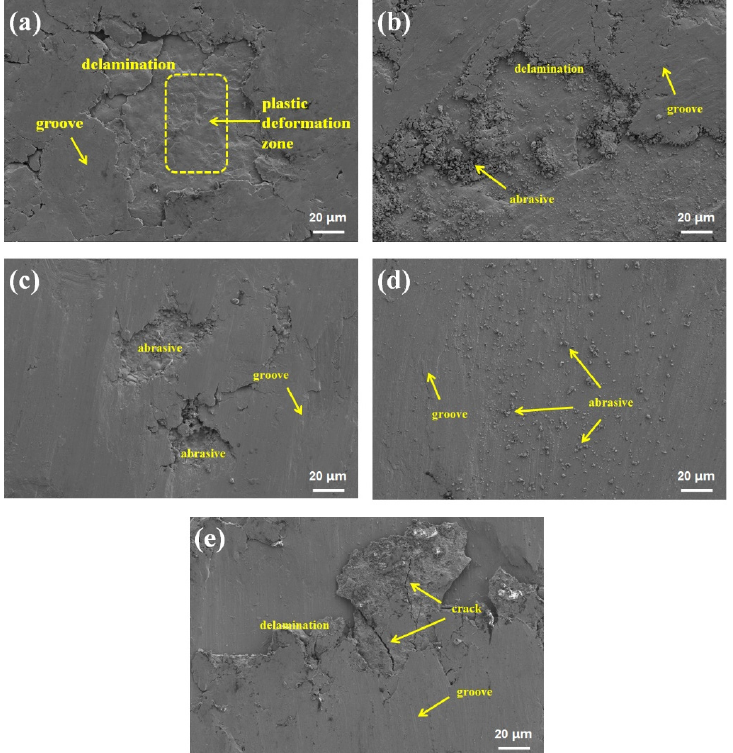
Figure 10. FESEM images of coatings after wear: ( a ) CoCrFeNi HEAC; ( b ) CoCrFeNi HEACC (10 wt.% WC); ( c ) CoCrFeNi HEACC (20 wt.% WC); ( d ) CoCrFeNi (30 wt.% WC); ( e ) CoCrFeNi HEACC (40 wt.% WC).